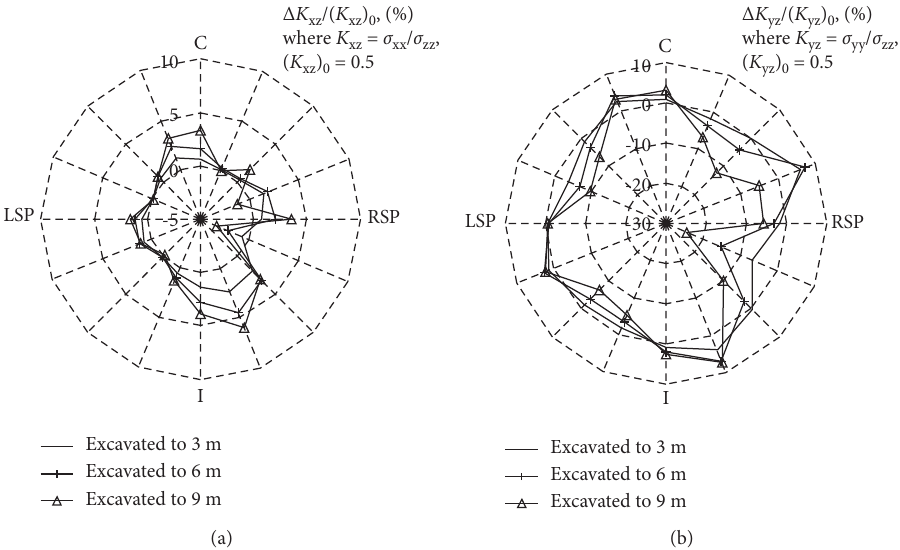
Figure 11: Changes in (a) K xz and (b) K yz for various soil elements at the excavation center section around the tunnel for case S (initial K xz � K yz � 0.5). Monitor elements: C, crown; LSP, left spring line; and RSP, right spring